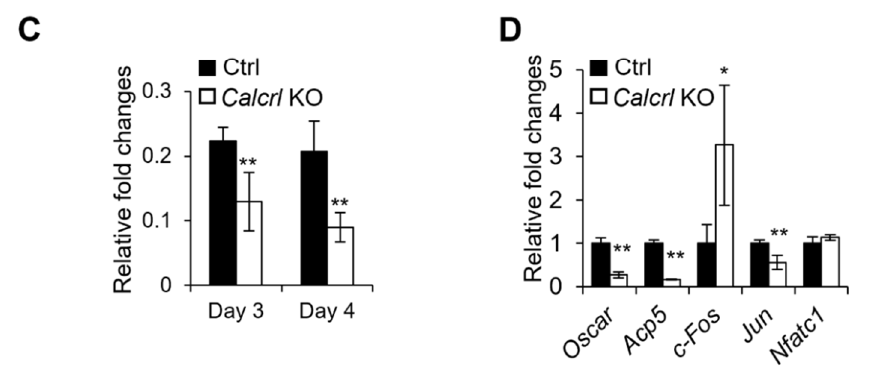
Figure 7. Calcrl is critical for MNC development. ( A ) Calcrl expression in the osteoclasts was detected with an immunofluorescence assay. BMMs were cultured for 4 days with M-CSF and RANKL stimulation. Scale bar, 100 µm. ( B ) Calcrl protein expression was detected using Western blotting on Ctrl (C) and Calcrl -knockout (KO or K) RAW 264.7 cells. The cells were differentiated into osteoclasts via RANKL stimulation. ( C ) The graph shows quantified Calcrl protein levels on Day 3 and 4 using Image J software ( n = 3). ( D ) The mRNA expression of osteoclast-related genes was examined using qRT-PCR in Ctrl and Calcrl -KO osteoclasts. The cells were harvested on day 3 after RANKL stimulation (*, p < 0.05; **, p < 0.01 compared to Ctrl).